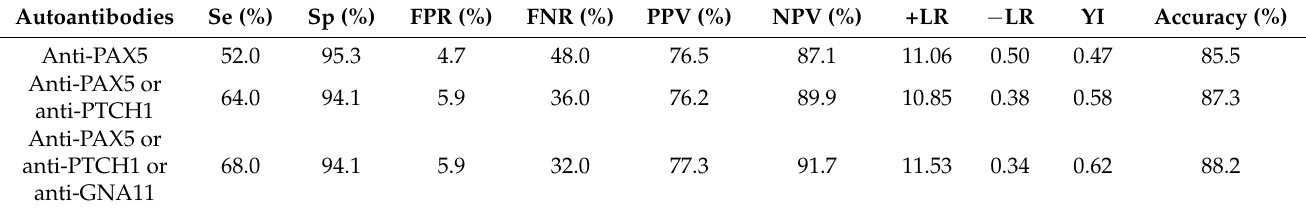
Figure 3. Performance of autoantibodies to PAX5, PTCH1, and GNA11 in the detection of HCC and LC. ( A – C ) performance of three autoantibodies in the identification of HCC from NC; ( D – F ) performance of three autoantibodies in the identification of HCC from CH; ( G – I ) performance of three autoantibodies in the identification of LC from NC. HCC, hepatocellular carcinoma; LC, liver cirrhosis; CH, chronic hepatitis; and NC, normal controls. Table 2. Performance of the combination of autoantibodies to PAX5, PTCH1, and